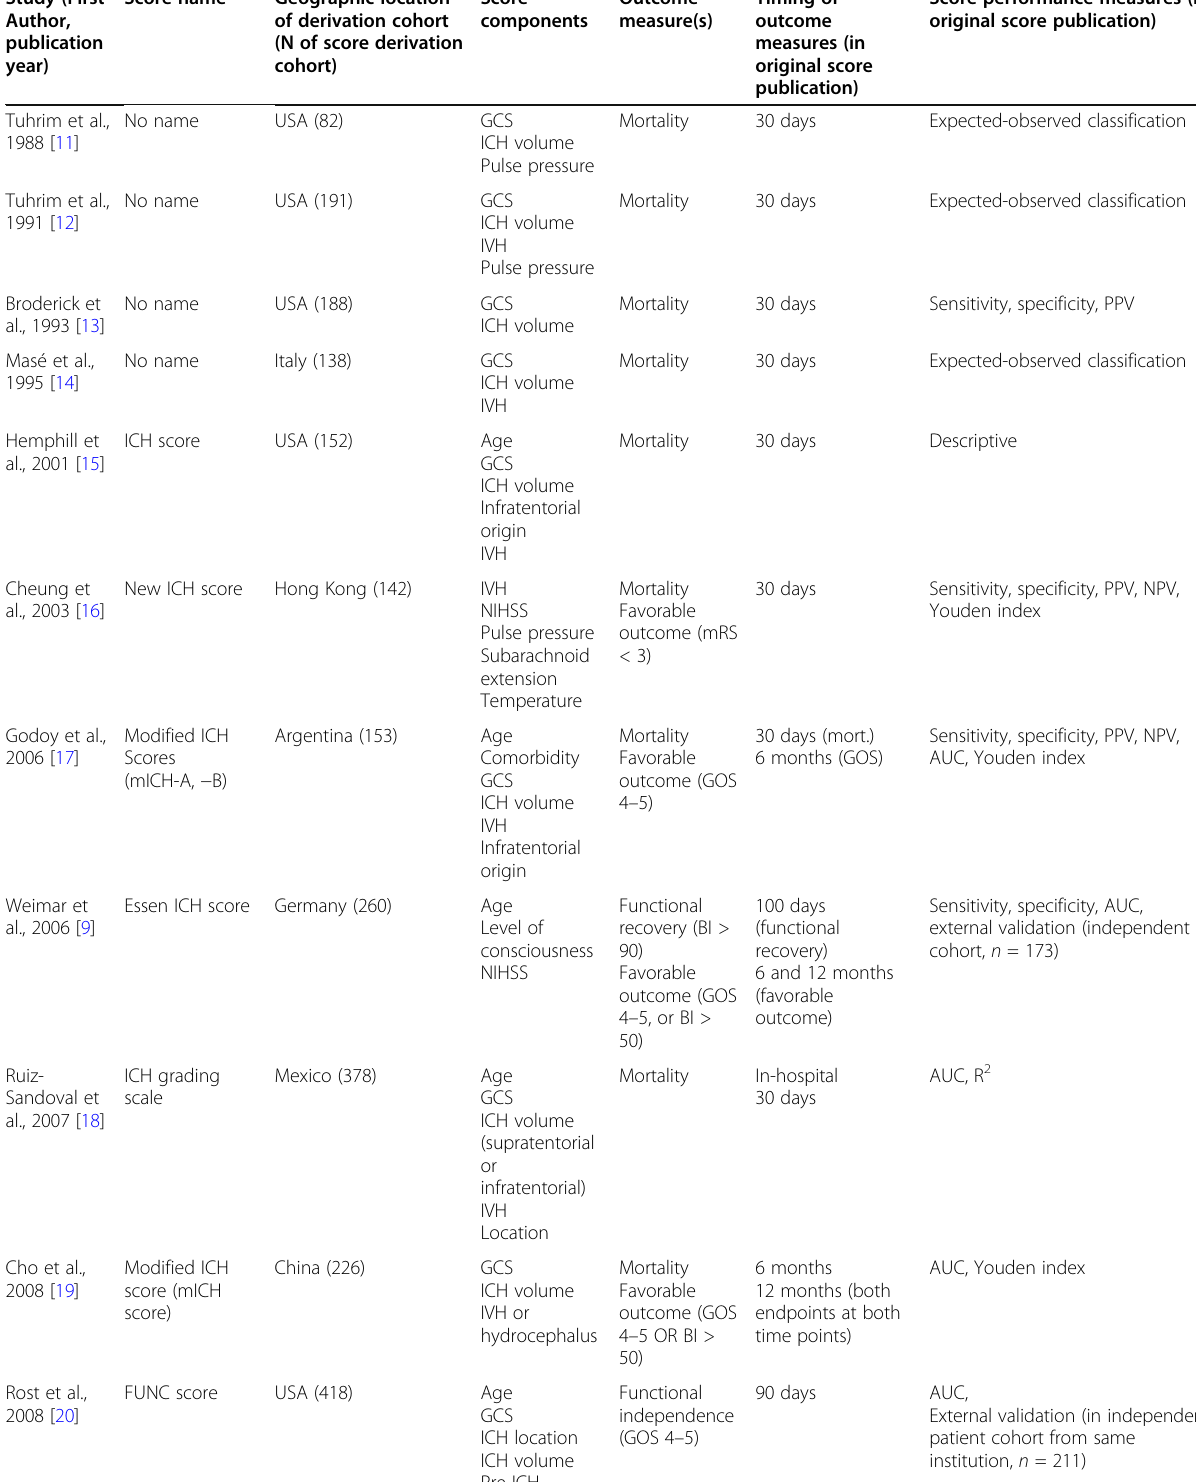
Table 1 Summary of Literature Search: scores to prognosticate outcome after spontaneous intracerebral